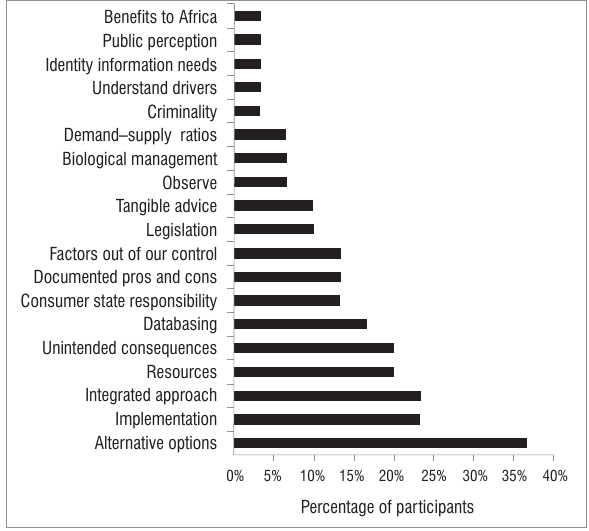
A summary of the expectations and issues that the 30 participants expressed at the workshop, some of which fell into more than one category.